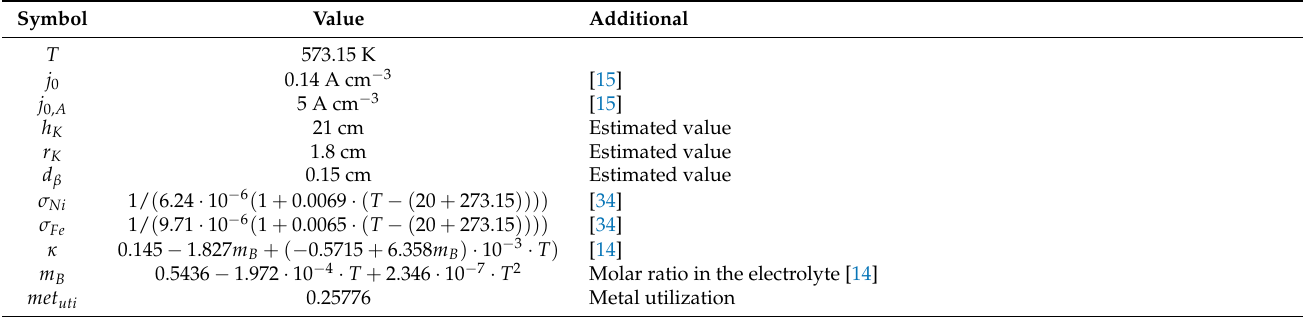
Table 3. List of model